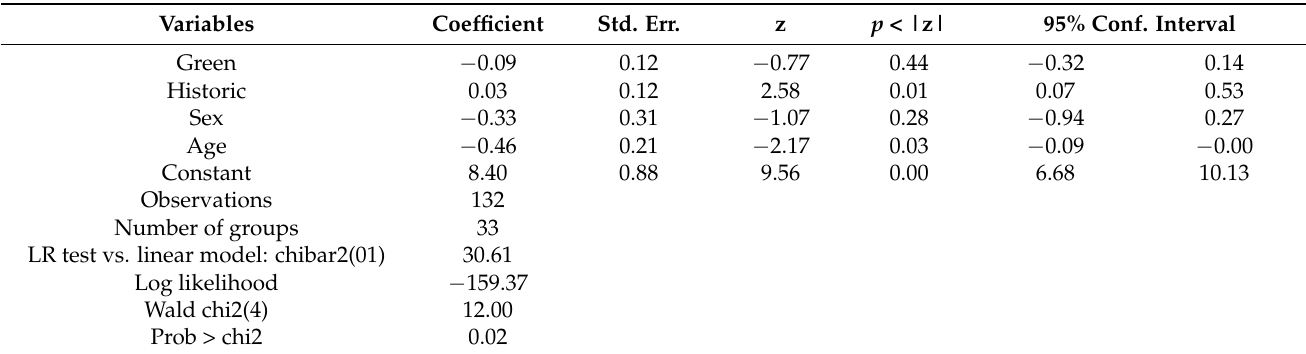
Table 6. Hedonic tone (Information Criterion